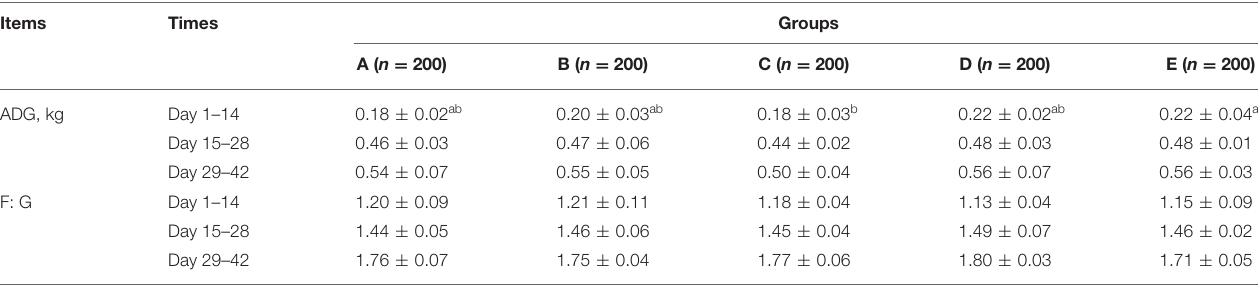
TABLE 4 | Effects of different calcium sources on average daily gain and feed to meat ratio of weaned